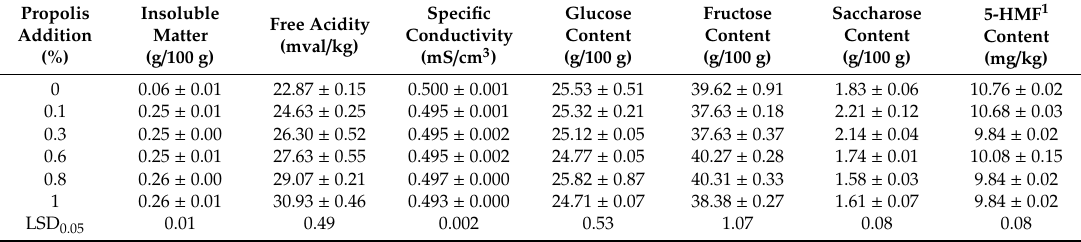
Table 5. The qualitative parameters of multifloral honey and the honey enriched with